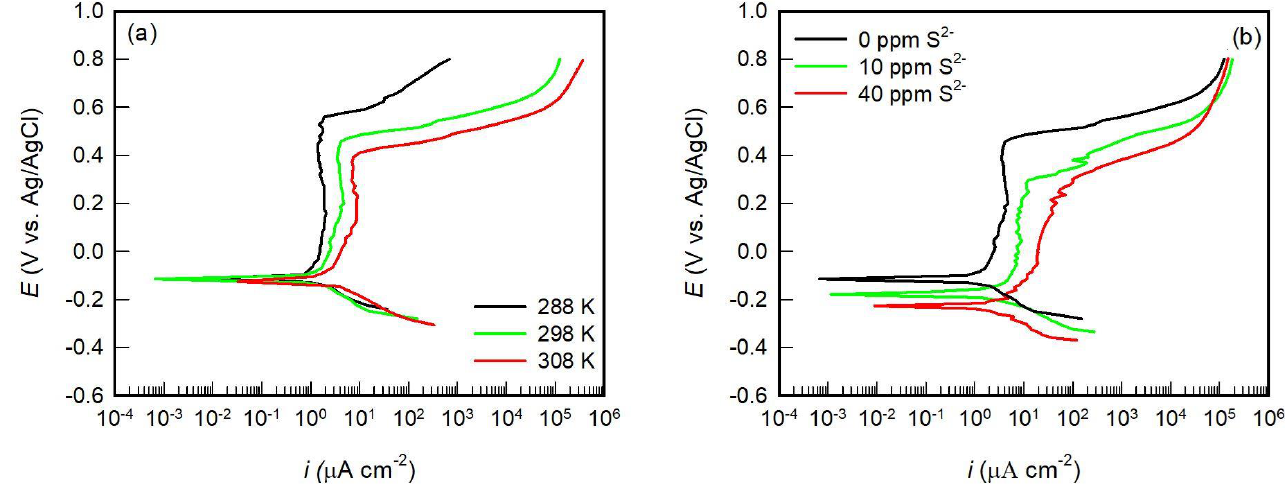
Figure 6. Potentiodynamic polarization curves for AISI 316L stainless steel in seawater at different ( a ) temperatures and ( b ) S 2− concentrations (at 298 K).